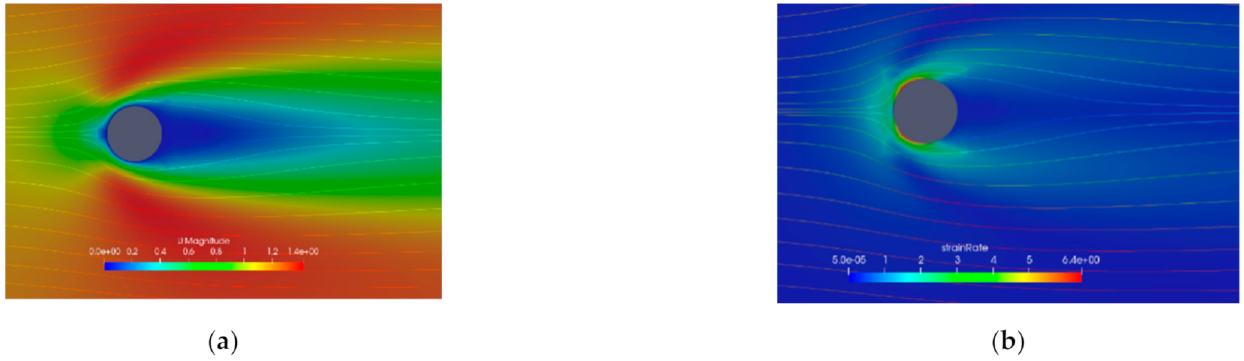
Figure 3. Flow field around a single cylinder, ( a ) velocity magnitude field, ( b ) Shear strain rate field.